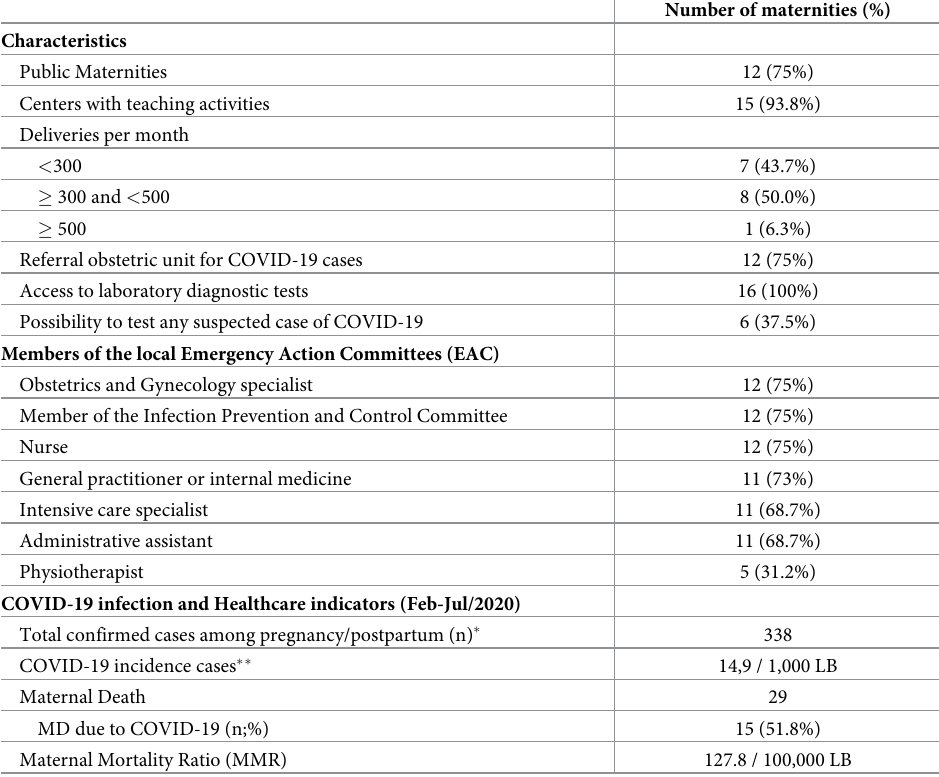
Table 1. Characteristics of included maternities in the REBRACO study (n = 16), participating members of the local Emergency Action Committees (EAC) and information on COVID-19 infection and some healthcare